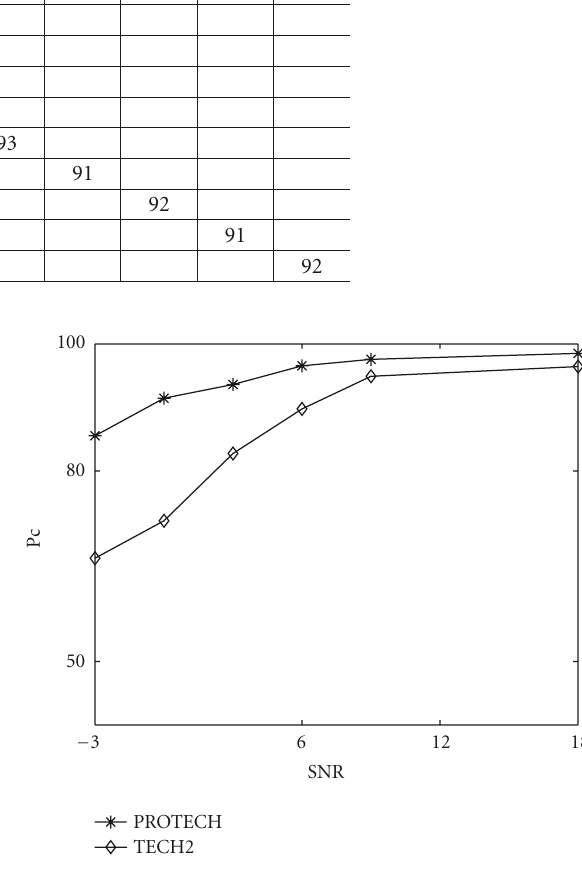
Figure 3: Comparison between the performances of PROTECH and